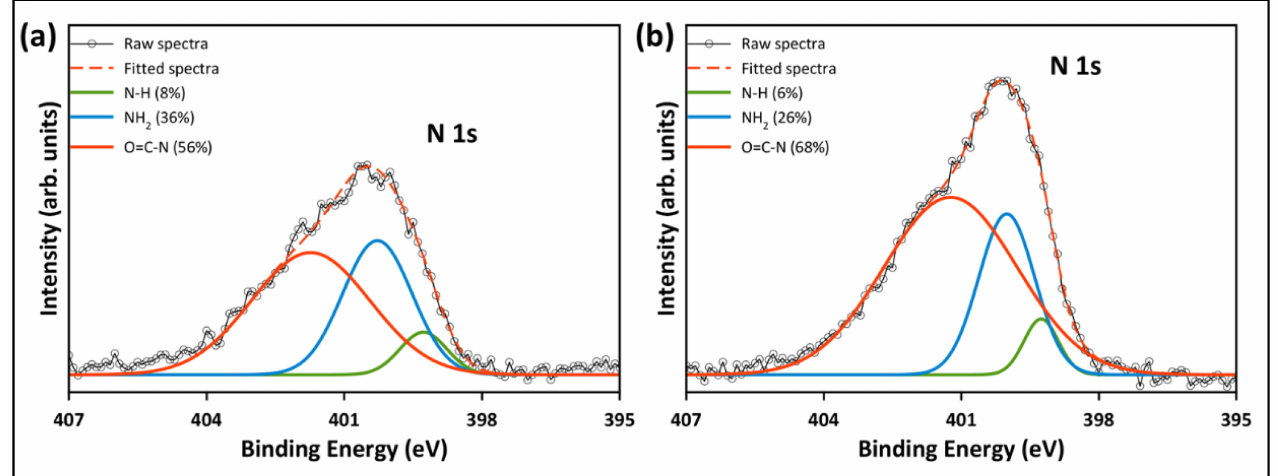
Figure 11. High-resolution XPS deconvolution of N 1s peak for ( a ) rGO-TEPA1 and ( b ) rGO-TEPA2. Table 3. Comparison of the experimental conditions, chemicals used, C/O ratio and reduction